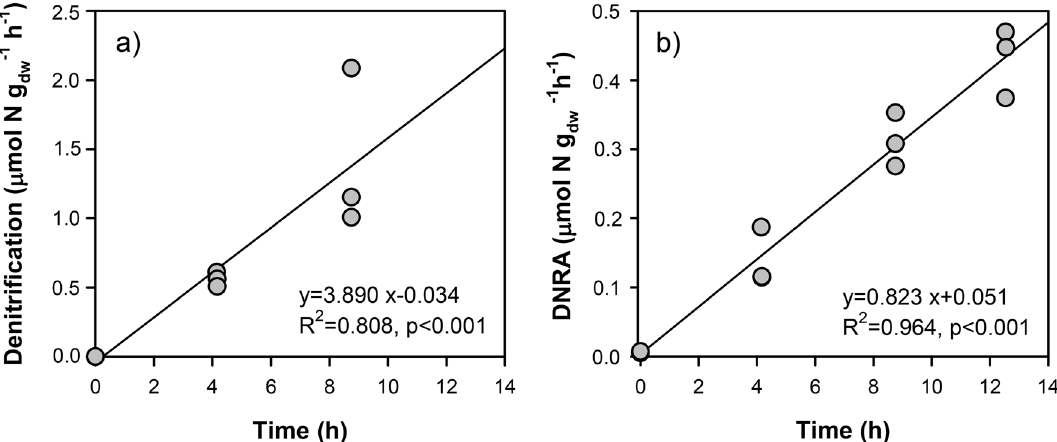
Figure 3. Nitrate reduction processes in crab carapace biofilm slurries: ( a ) production of N 2 via denitrification and ( b ) production of NH 4+ via dissimilative nitrate reduction to ammonia (DNRA). Biofilm slurries were amended with 15 NO 3− and incubated over a period of 12 h, and represent potential rates. Note that production of N 2 is not shown for the last time point as it exceeded the measuring rage of the instrument. Both potential rates are expresses as micromoles of N per g dry weight of suspended biofilm.